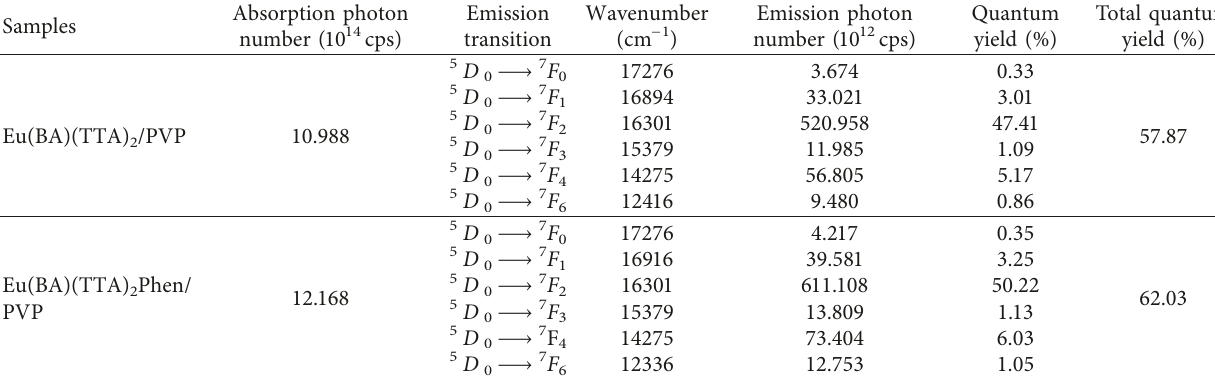
2 /PVP (a) and Eu(BA)(TTA) 2 Phen/PVP (b) under 367nm UVA-LED excitation. 2 /PVP and Eu(BA)(TTA) 2 Phen/PVP fibers under